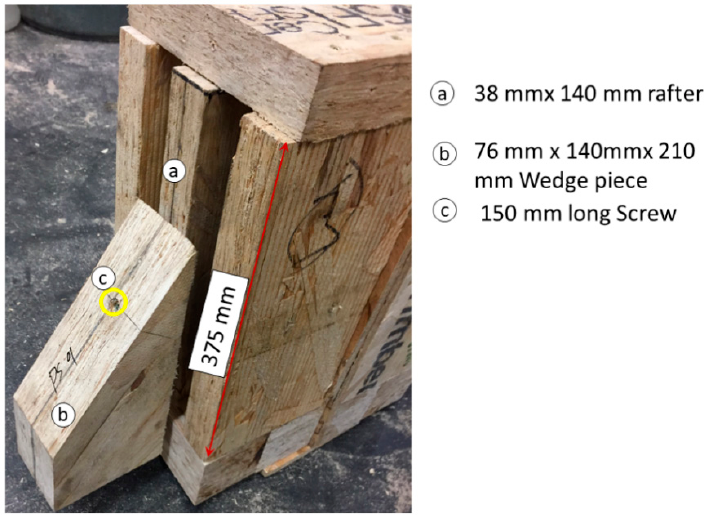
Figure 10. Connection-E specimen.